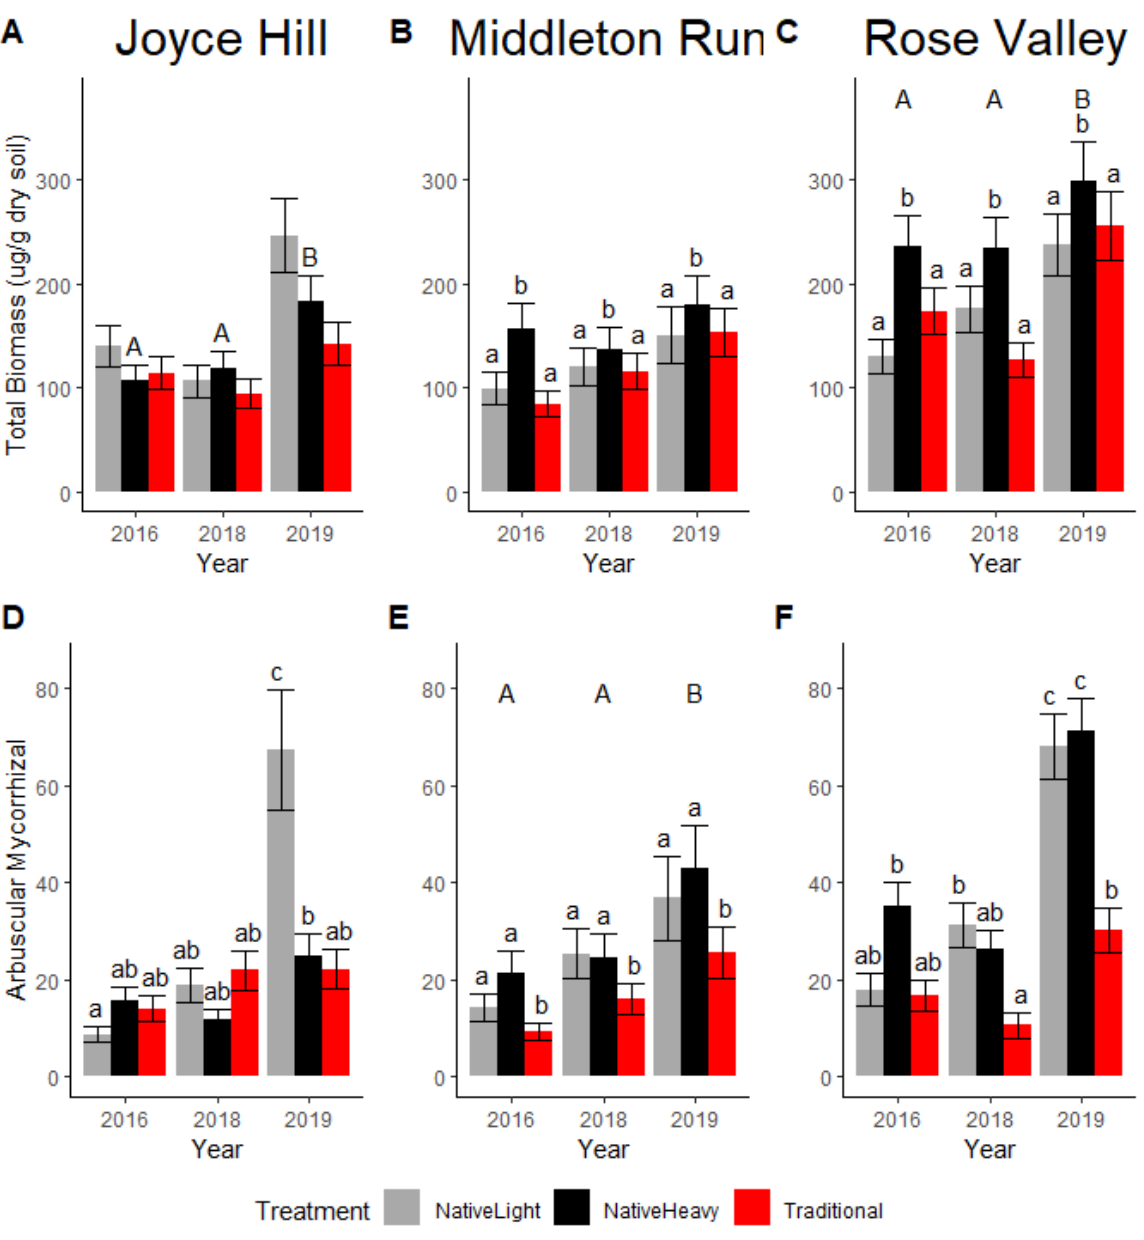
Figure 5. Total phospholipid fatty acid methyl-ester (FAME) content (nmol g − 1 ; A – C ) and arbuscular mycorrhizal fungi content (nmol g − 1 ; D – F ) at Joyce Hill, Middleton Run, and Rose Valley. Values are estimated marginal means with one standard error. Seed mix treatments with the same capital letter or growing seasons with the same lower-case letter are not significantly different. Arbuscular mycorrhizal fungi responded to an interaction between growing season and seed mix treatment at Joyce Hill ( D ) and Rose Valley ( F ).